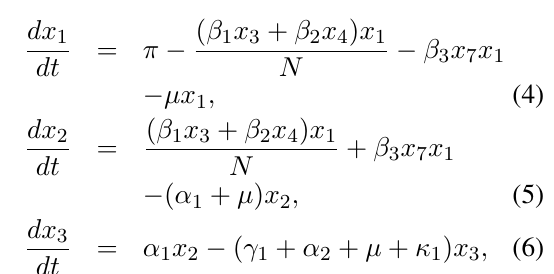
where ε g is the baseline exposure from the com- munity, f g is a time dependent curve that modifies the community rate of exposure over time and ψ i, age accounts for disease susceptibility depend- ing on